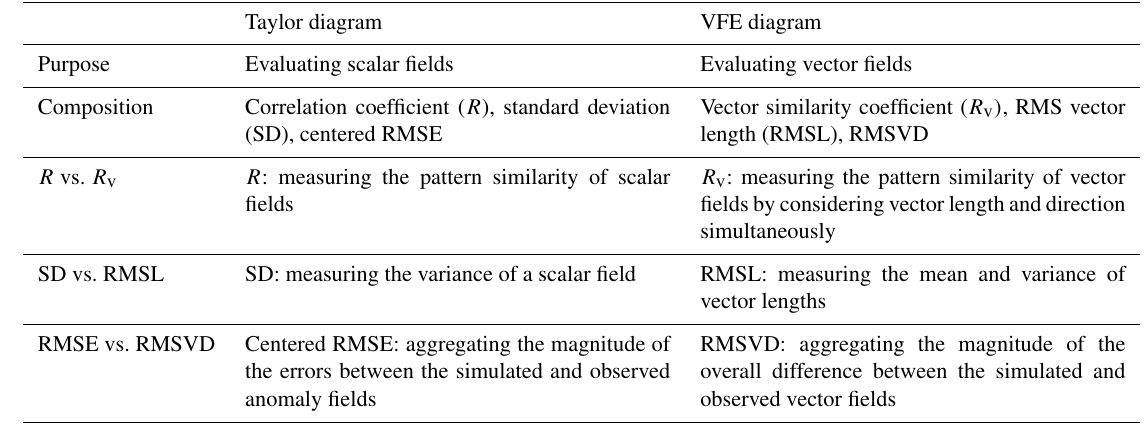
Table 1. Summary of the difference between the Taylor diagram and the VFE diagram.